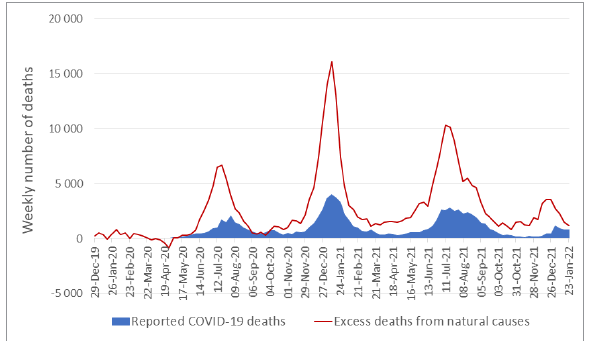
Figure 2: Weekly number of excess natural deaths and reported COVID-19 deaths in South Africa, 29 December 2019 – 5 February 2022.